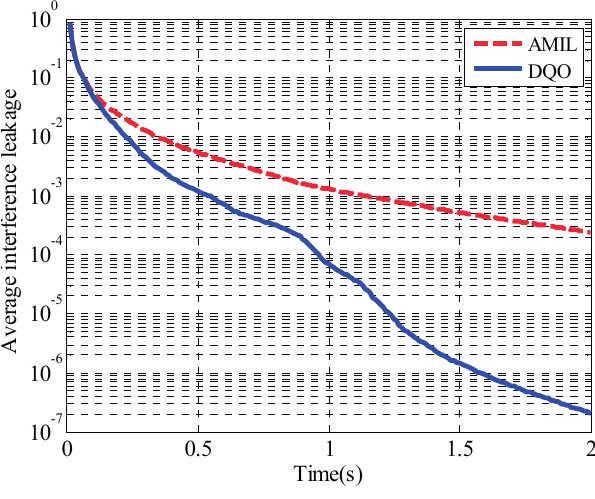
Figure 7. Convergence curves of the average interference leakage in (5 × 5, 2) 4 .